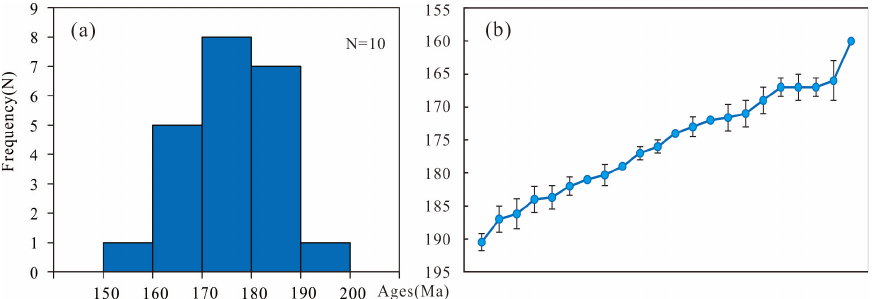
Figure 8. ( a ) Age distribution of the ultramafic rocks. ( b ) Summary of the ages for ultramafic rocks. The ages are listed in Table 1, data from Bangong–Nujiang ophiolite belt and the adjacent Neo-Tethys ophiolite belt.